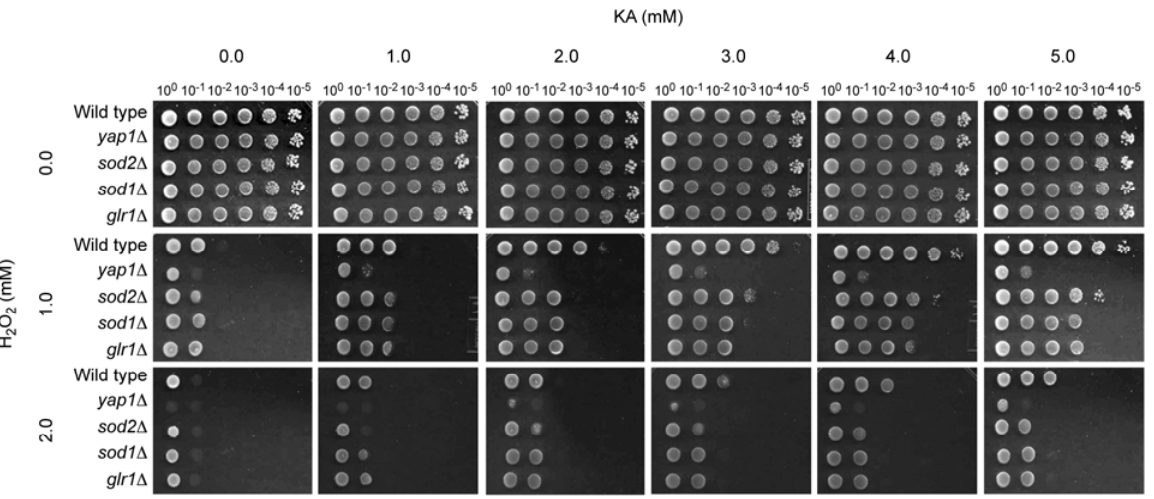
Figure 4. Agar (SG)-based yeast-cell dilution bioassay showing antioxidant effect of KA O -treated S. cerevisiae strains (10 0 to 10 − 5 : yeast dilution to H 2 2